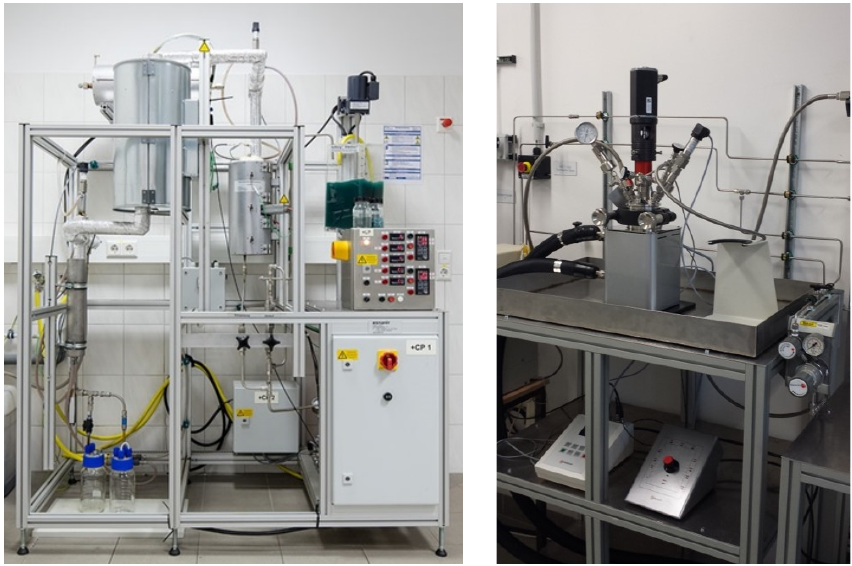
Figure 2. Photographs of the continuous reactor ( left , cf. Section 2.1) and the batch reactor ( right , cf. Section 2.3, part 1).